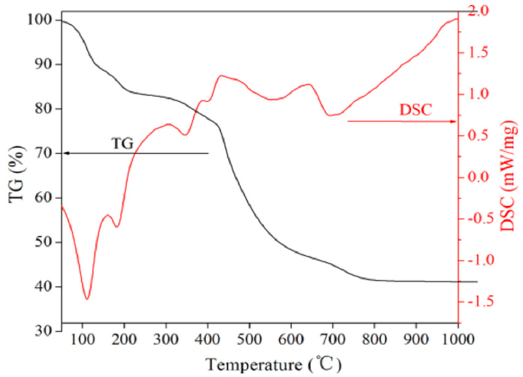
Figure 9. TG-DSC curves of RE oxalates in air atmosphere (negative value is exothermal). Table 5. Loss-weight rate of RE oxalates at different temperature.